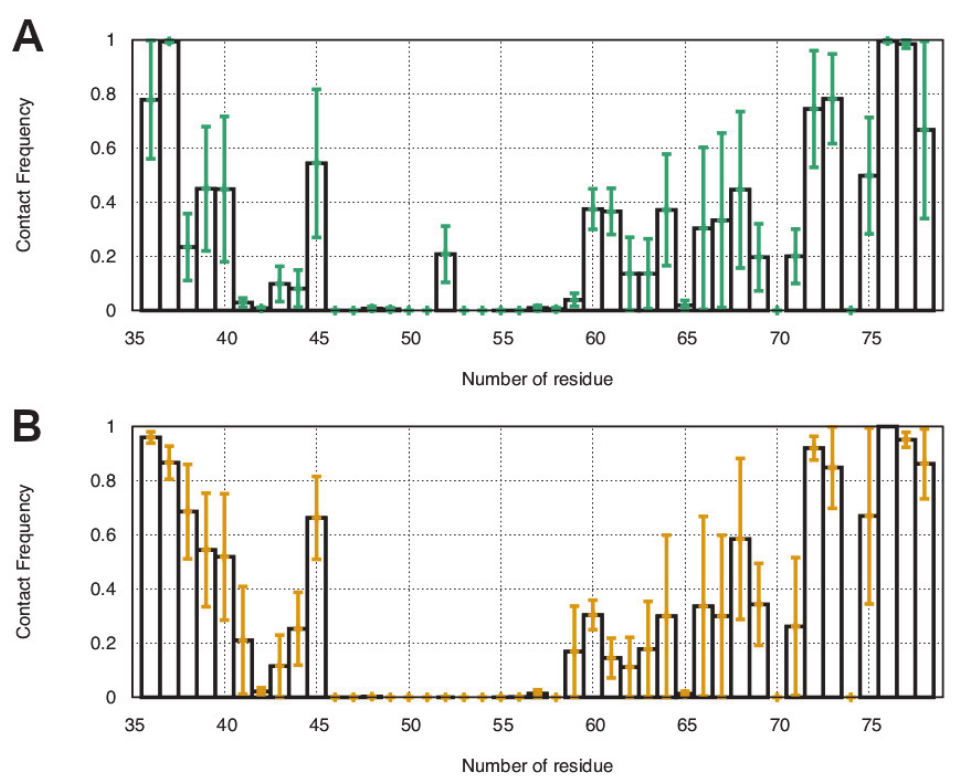
Figure 5. Contact frequency between each wt:p10 residue and the dsDNA in complexes 2 ( A ) and 4 ( B ). The standard errors of the mean between replicates were calculated and are highlighted with the green and yellow bars.